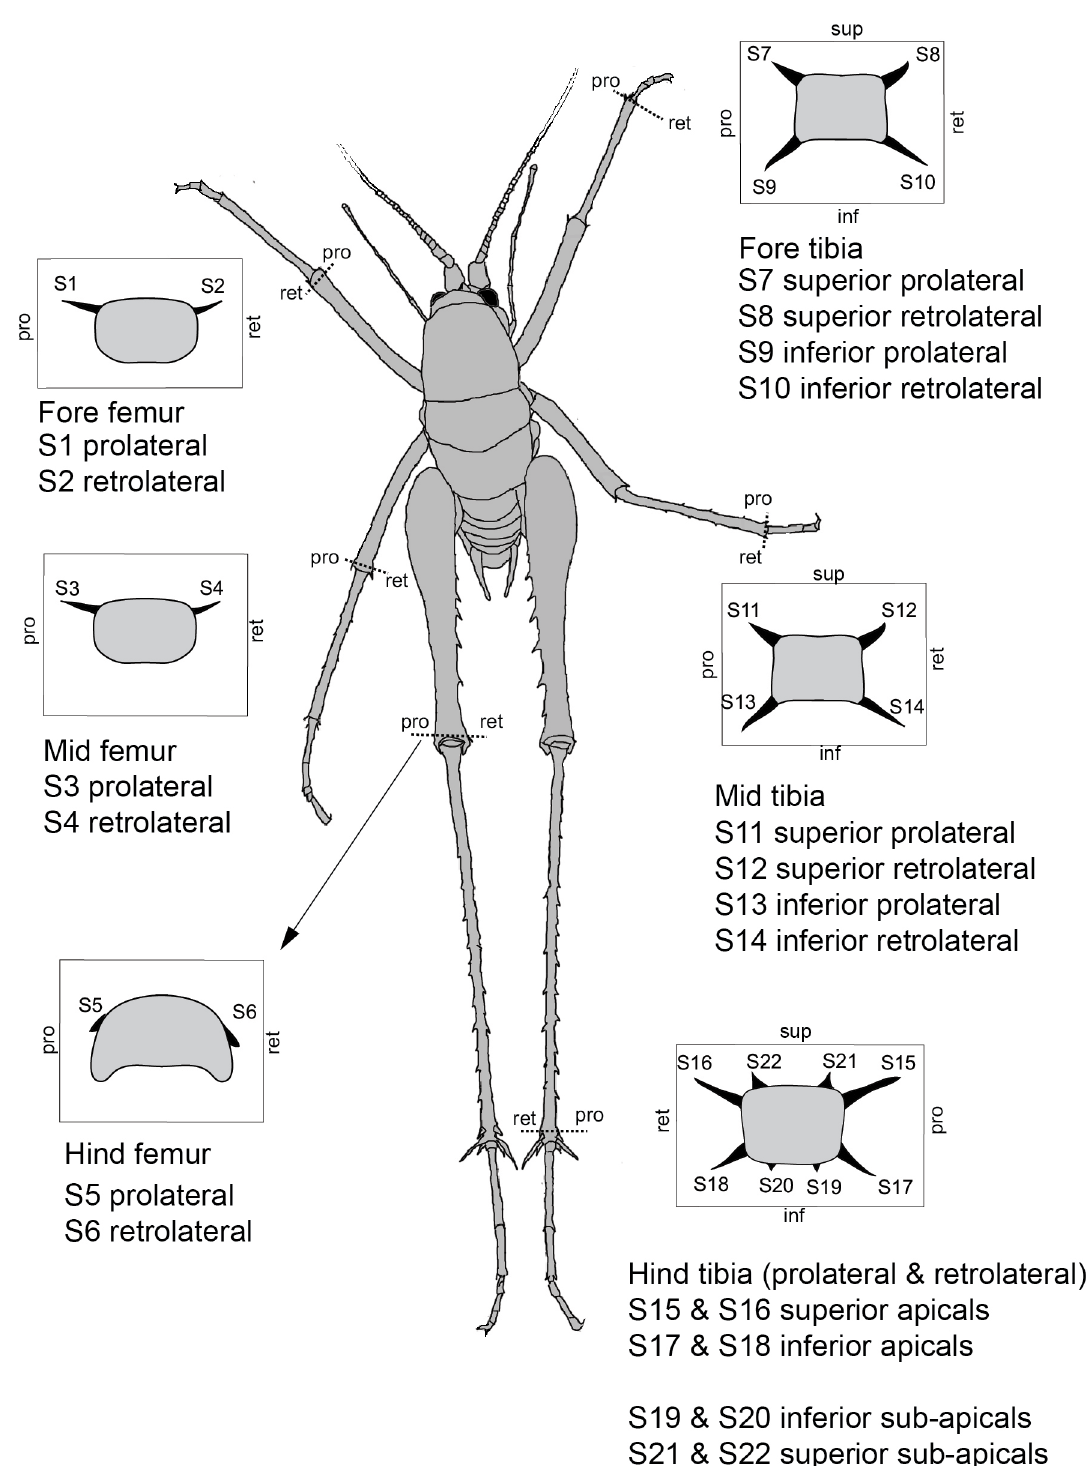
Fig. 1. Apical spine numbering, terminology and position on rhaphidophoridae, after Fitness et al. (2015). Dorsal view, showing cross-sectional relationship of each potential spine on femora and tibiae. Positions are indicated as prolateral (anterior facing), retrolateral (posterior facing), inferior (ventral facing) and superior (dorsal facing) orientations are